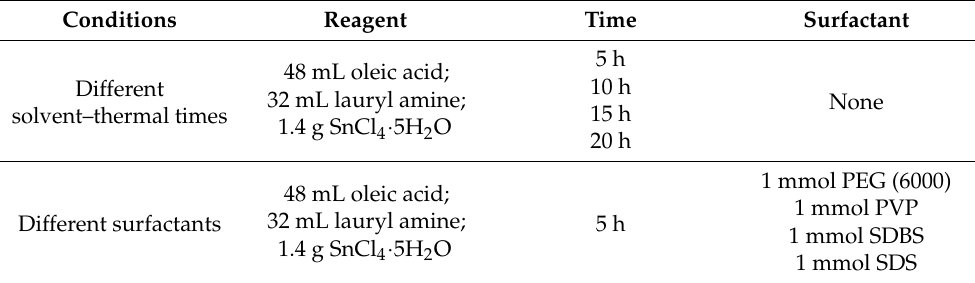
Table 1. Different experimental parameters of SnO 2 prepared by solvothermal method.